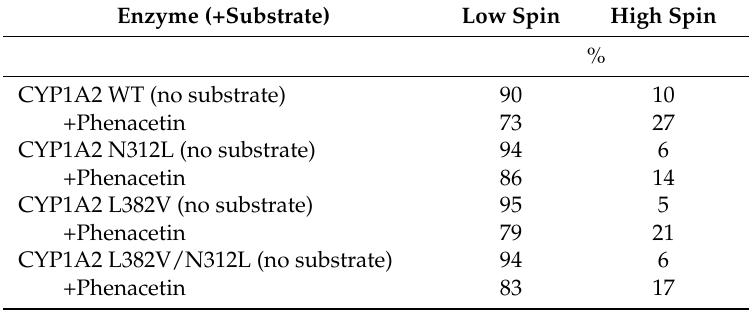
Table 2. Percentages of low spin and high spin in CYP1A2 WT and the mutants in the absence and the presence of phenacetin at 27 ◦